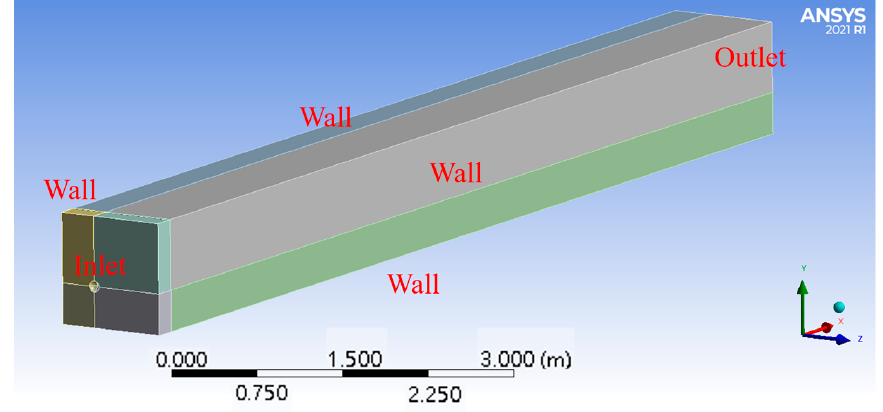
Figure 5. Rectangular cuboid model constructed in this study.